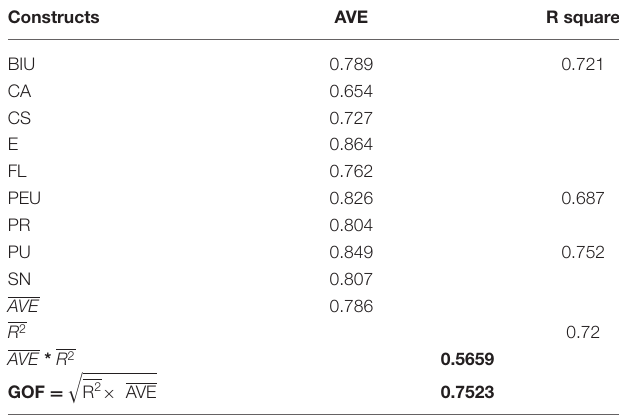
TABLE 8 | Goodness-of-fit (GoF) index.